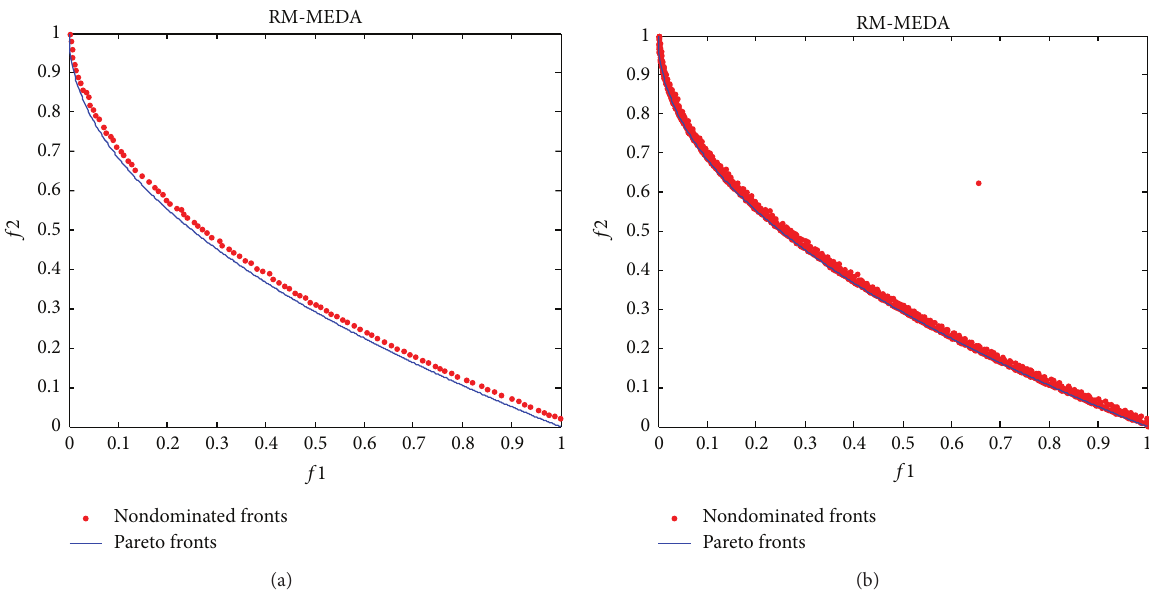
Figure 9: The final nondominated solutions and fronts found by RE-MEDA. (a) The result with the lowest 𝛾 -metric and (b) all the 10 fronts in 10